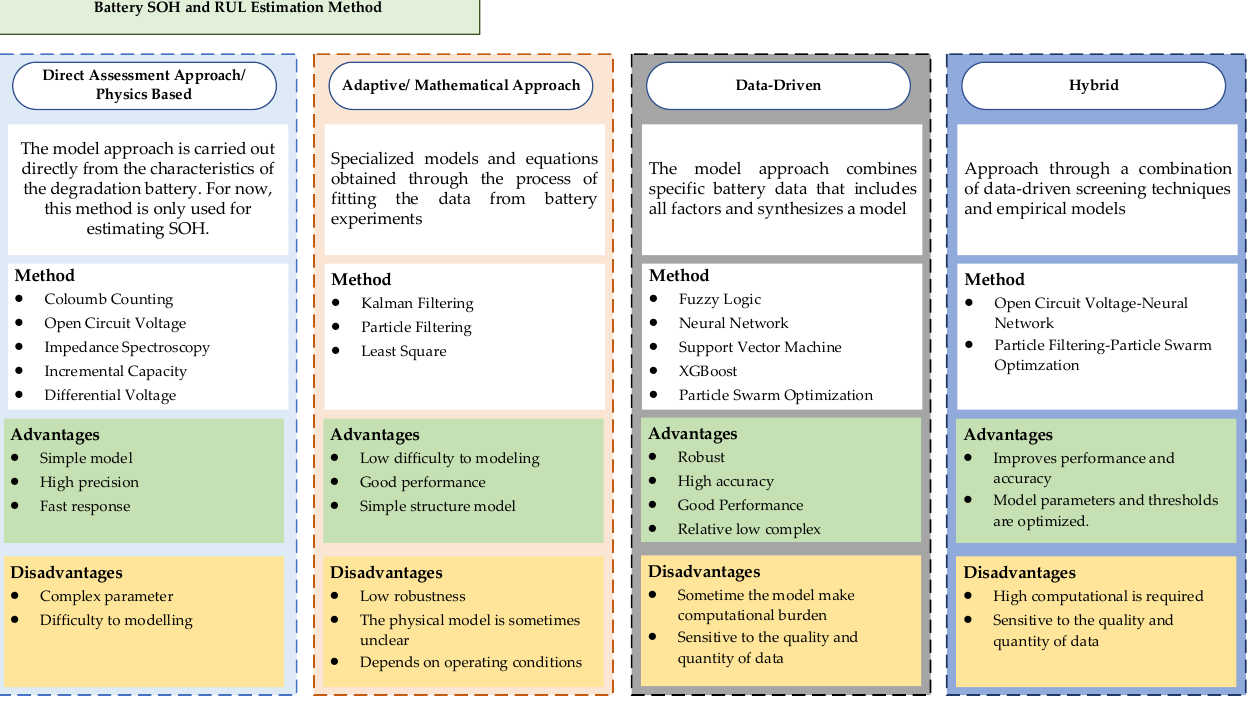
Figure 9. Classification method estimation RUL battery [76,82]. Table 9 reviews variables used to optimize BESS capacity size and placement with battery degradation models, which vary in different studies. Aside from the SOH and RUL models, preliminary research also used fading capacity and residual battery life for BESS optimization. Table 10 reviews the algorithm used for battery degradation models for BESS optimization. Table 9. Review of variable features used in battery degradation models for optimization of BESS sizing and siting.